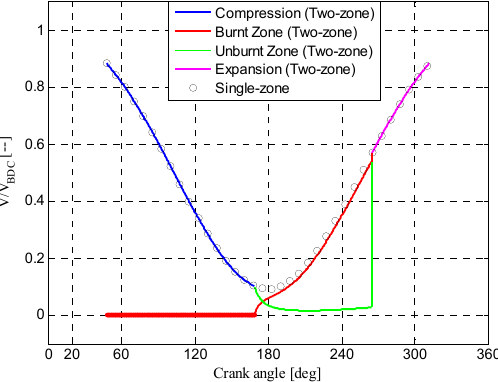
Figure 8. In-cylinder temperature in two-zone models and single-zone models.